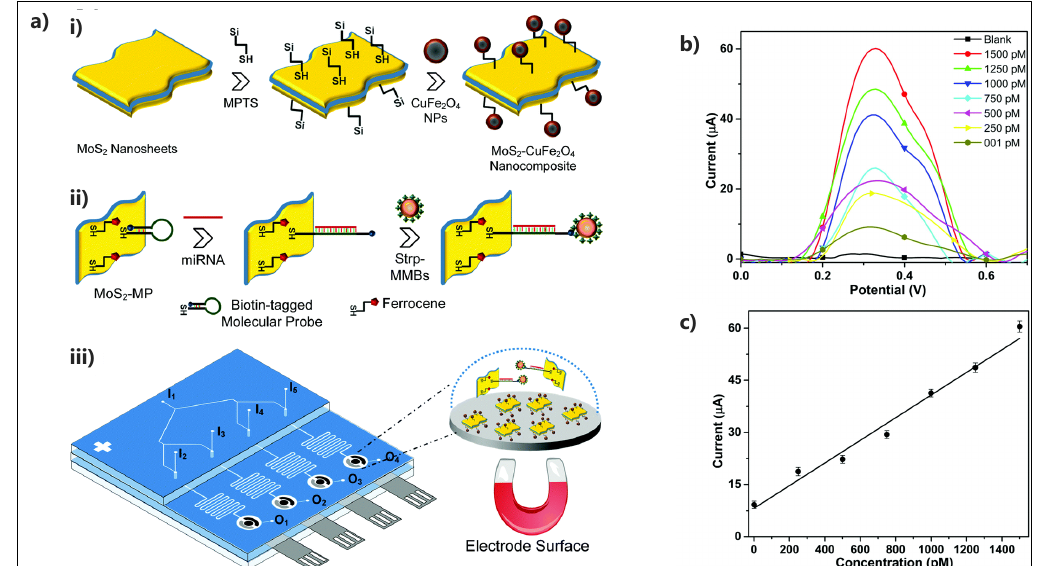
Figure 9. ( a ) Schematic illustration of ( i ) MoS 2 –CuFe 2 O 4 nanocomposite synthesis, (ii) step-wise detection of target miRNA while using MoS 2 -MP nanocarriers and (iii) fabricated microfluidic platform consists of inlets (I 1 -I 5 ), reaction and sensing zones and outlets (O1-O5); ( b ) Detected DPV signals for various concentrations of nominal miR-205 and ( c ) the corresponding linear curve for the obtained DPV data. Reproduced with permission from [141].